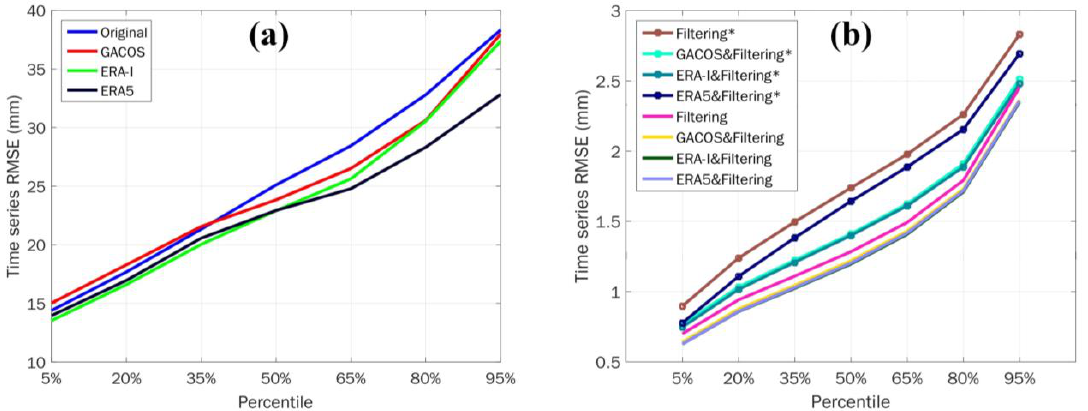
Figure 8. Percentile plots of the time series RMS of the tropospheric noise derived over the whole study area. ( a ) No correction, GACOS, ERA-I, or ERA5 derived corrections. ( b ) Corrections using StaMPS spatiotemporal or its integration with GACOS, ERA-I, or ERA5. The entries “*” in the legend represent the corrections with the primary TOE retained in interferograms.